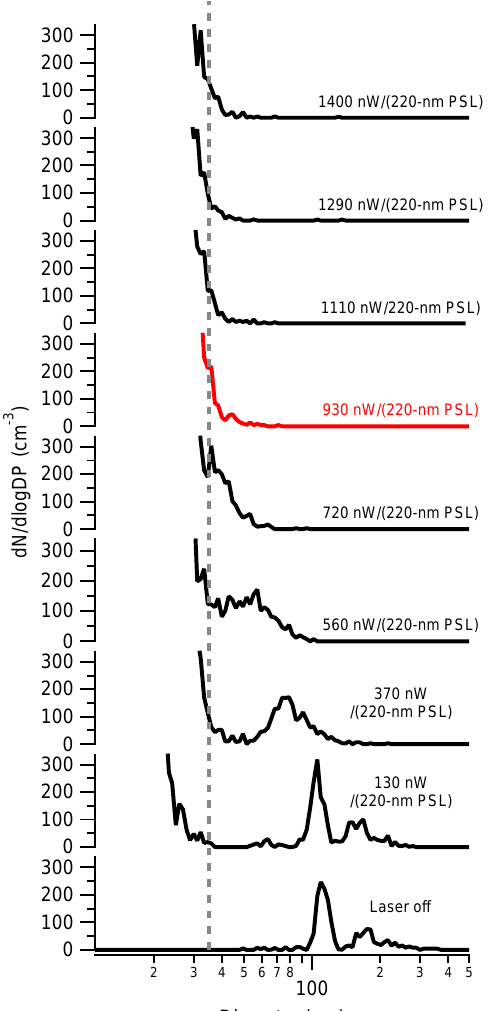
Figure 2. The size distribution of 125nm Aquadag ® SP2 ex- haust as a function of SP2 absolute laser power. As shown, the original Aquadag ® particle is only partially ablated until 930nW / (220nmPSL) (red curve), where is it fully vaporized.